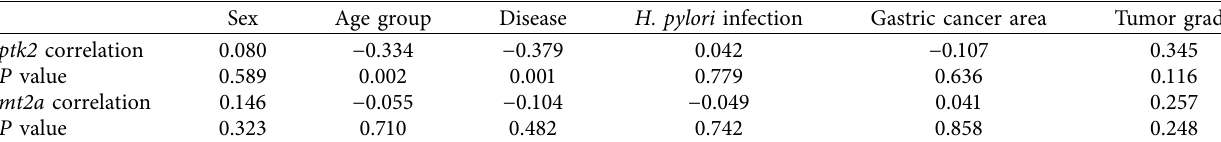
Table 6: Correlations between ptk2 and mt2a Δ Ct and patients’ demographic